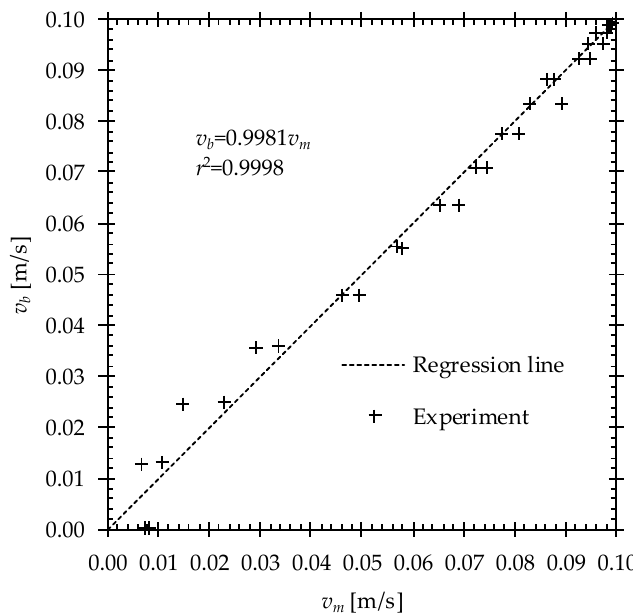
Figure 7. The plot of the experimental results and regression line Equation (23).